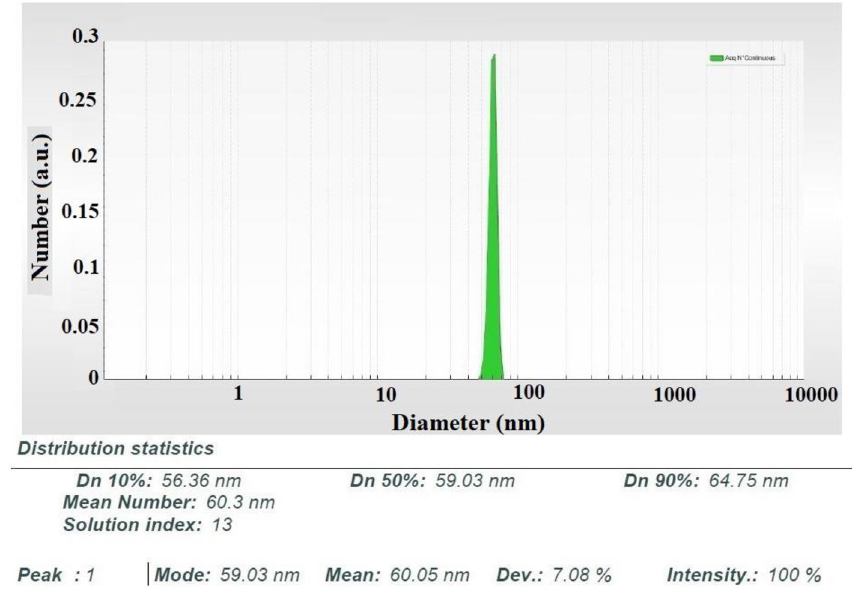
Figure 1. The mean size of produced nanoparticles recorded by the nanosizer equipment (DLS technique).